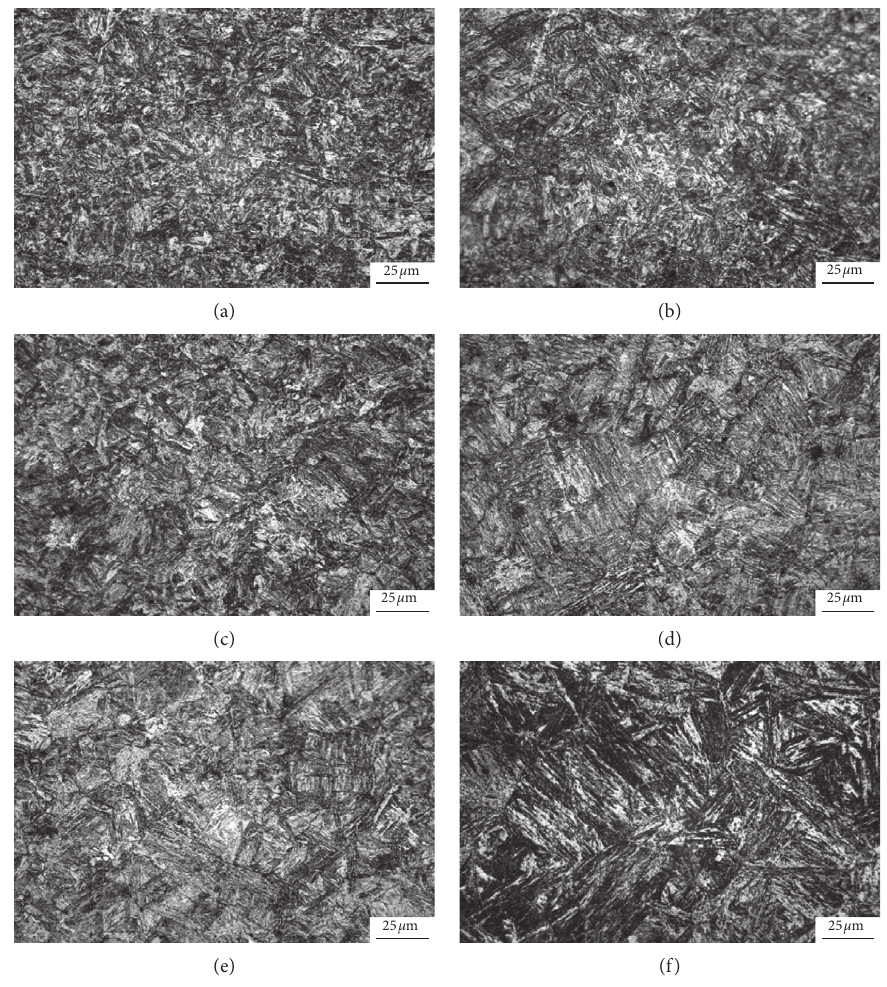
Figure 6: Microstructure of BR1500HS under different cooling rate: (a) 20 ° C/s, (b) 30 ° C/s, (c) 40 ° C/s, (d) 50 ° C/s, (e) 70 ° C/s, and (f) 100 °